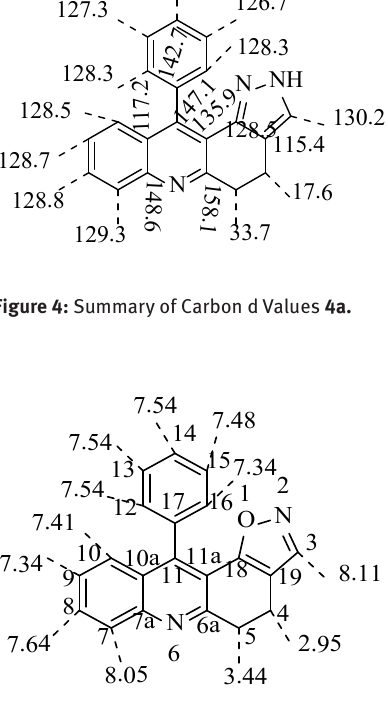
Figure 5: Summary of Proton d Values 5a.